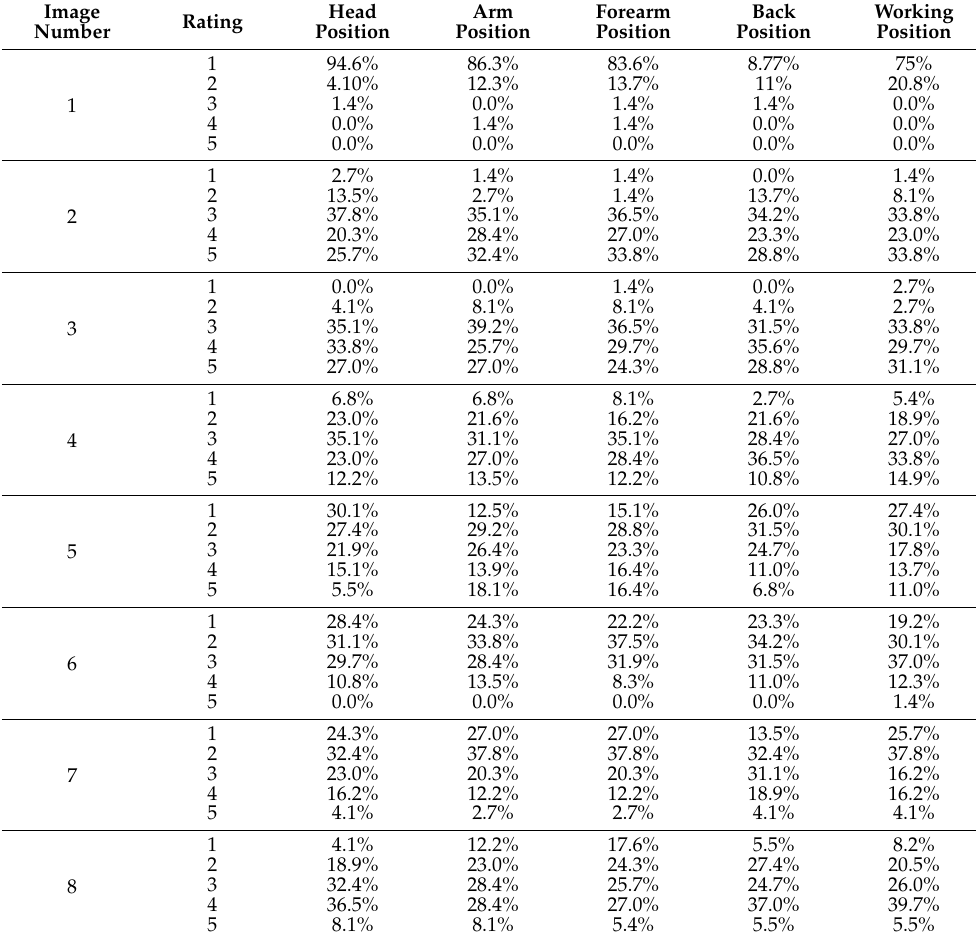
Table 4. Image number 1, 2, 3 and 4 rating based on the characteristics described in the ISO11226. Image number 5, 6, 7 and 8 rating based on the characteristics described in the